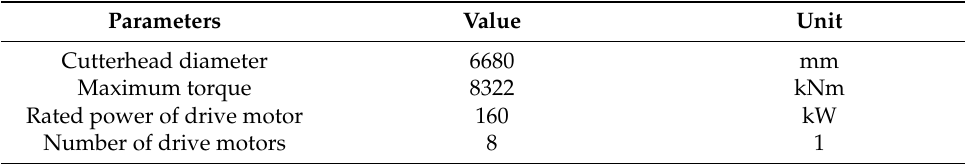
Figure 4. Geological sampling results and the TBM used. ( a ) Geological sampling results. ( b ) The TBM used. Table 1. Basic parameters of the TBM